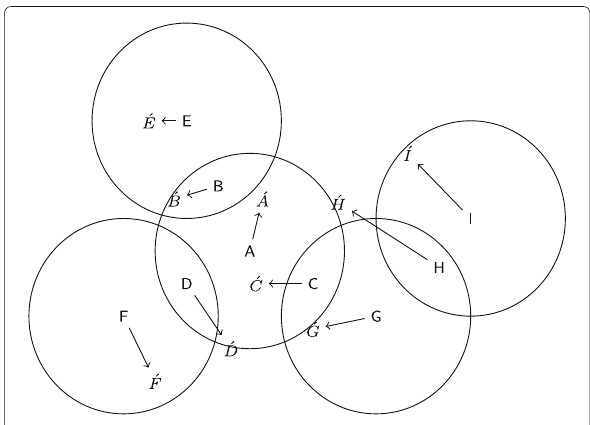
Fig. 14 Problem of endcast in the presence of